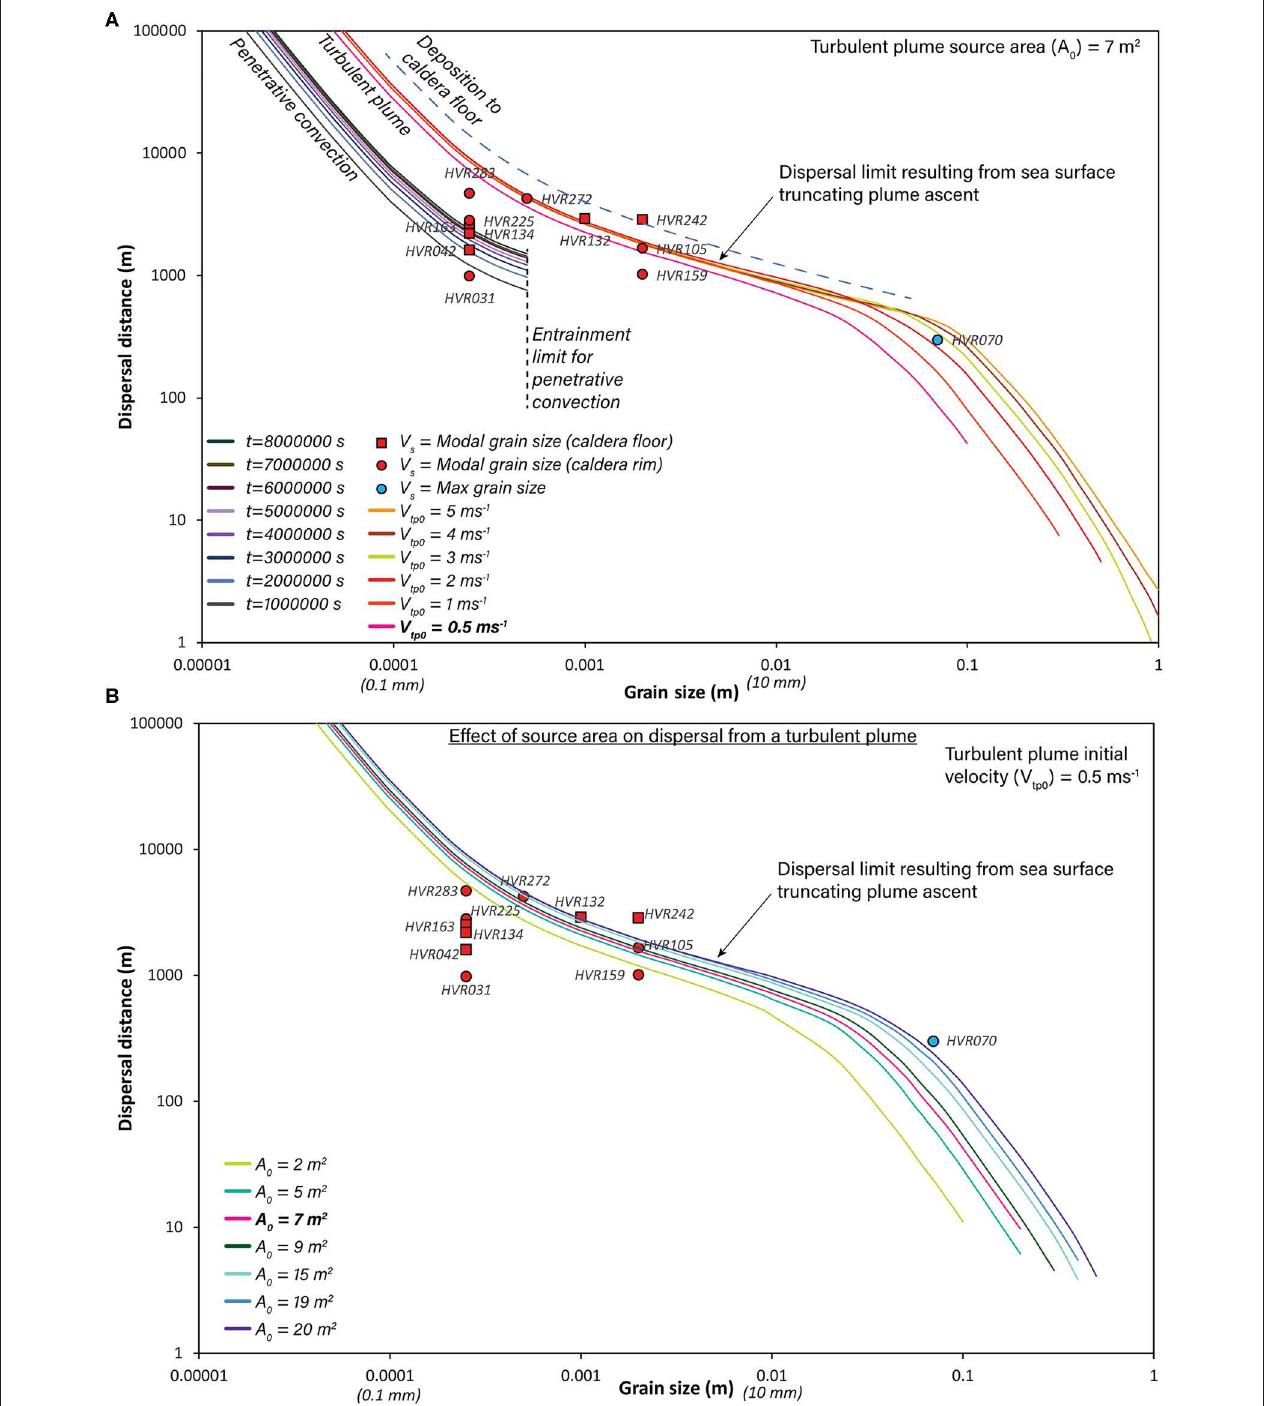
FIGURE 11 | (A) Graph of grain size plotted vs. maximum dispersal distance calculated for both a turbulent plume and penetrative convection using the methods outlined in the text and in Figure 9 . The distances from Lava G and the modal grain sizes of ETV grains from samples that contain S3 are also plotted. The symbols indicate those that were collected from the caldera rim (circles) and those that were collected from the caldera floor (squares). The majority of samples plot below the line for dispersal from a turbulent plume when V tp0 > 1m s − 1 . The only samples that plot above the line are two deposited on the caldera floor. The dispersal model presented assumes deposition on a flat plane the same depth as the source, however at Havre there is a 500m difference in height between the caldera rim and caldera floor. The dashed line therefore shows the position of the V tp0 > 1m s − 1 max dispersal limit for the same model calculated for deposition on a surface 500m